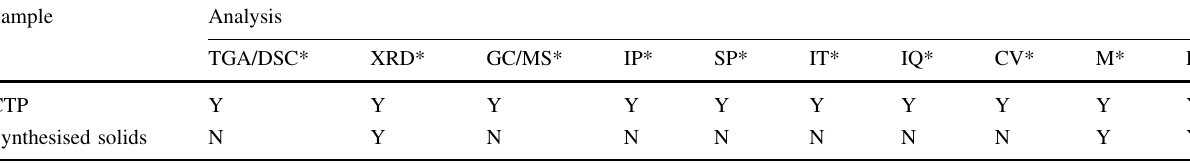
Table 1 Analysis for tar and CTP samples Sample